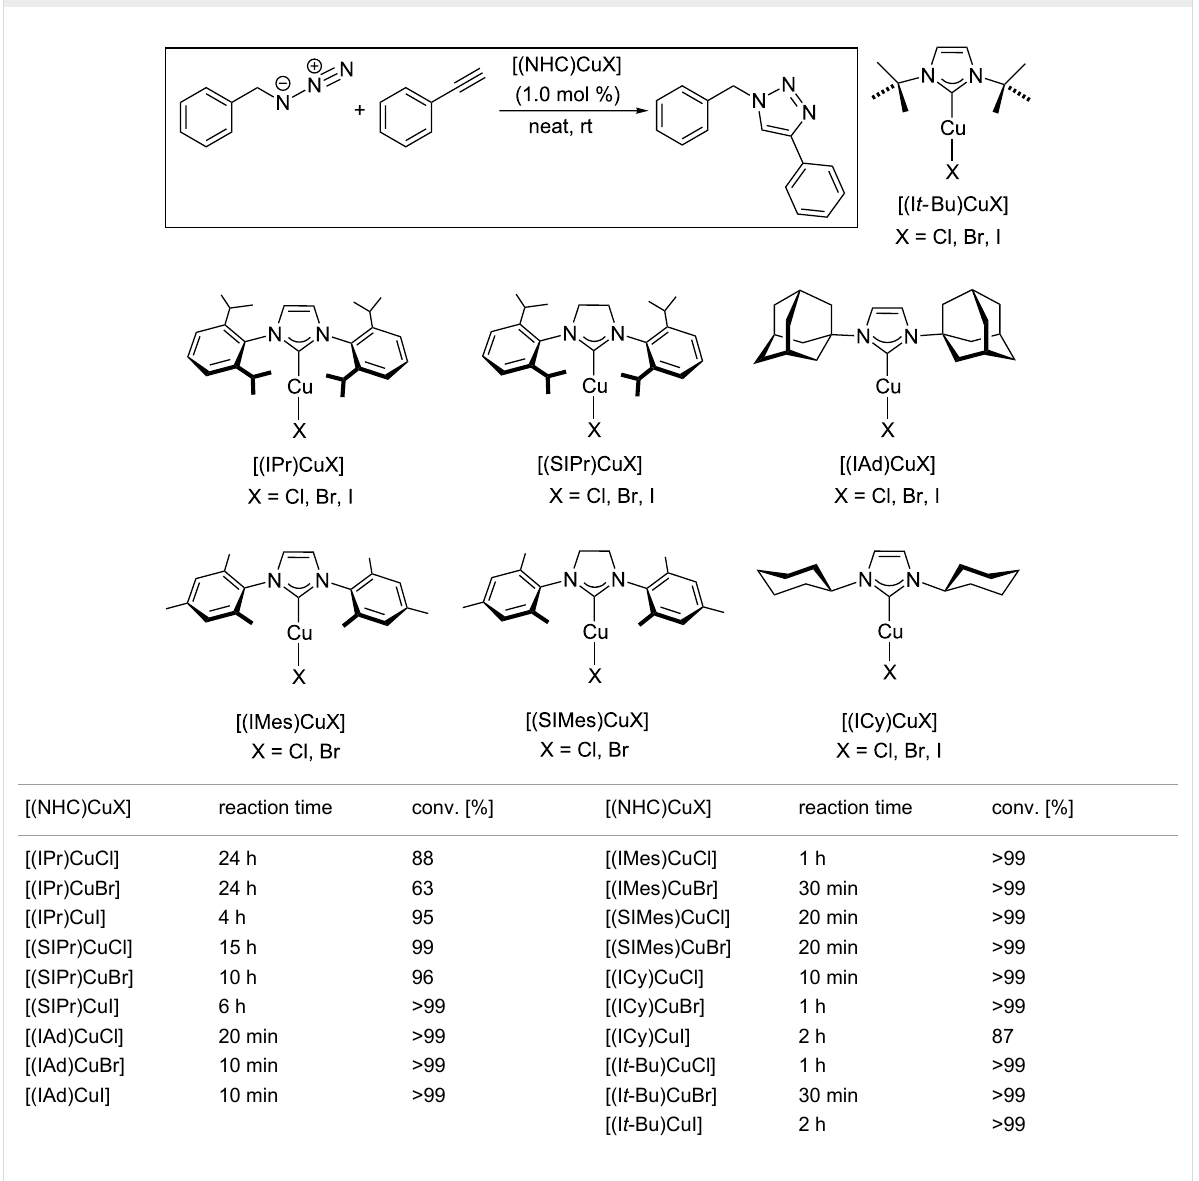
Table 2: CuAAC catalysts of type [(NHC)CuX] and their performance in the CuAAC test reaction